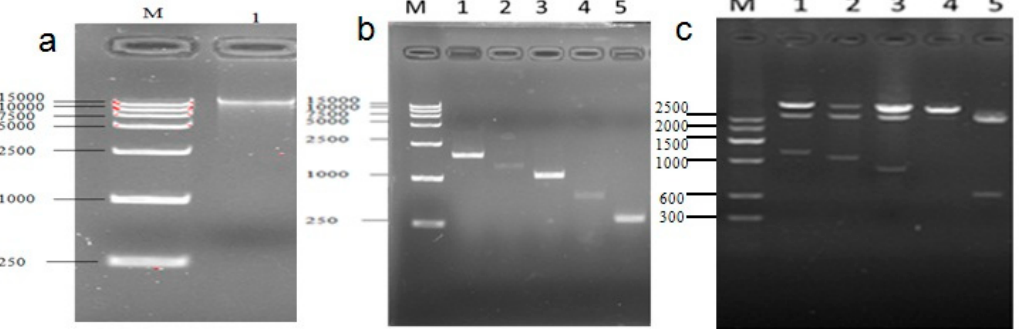
Figure 9. Cloned and identified sequence of the cattle UCP3 promoter ( a ) The electrophoretogram of DNA, the product was run on a 1.5% agarose gel; ( b ) Different PCR products of UCP3 promoters; ( c ) Restriction analysis Identification of pUCm-T-ucp3-pro. Table 4. Sequences of primers of UCP3 promoter used for PCR.